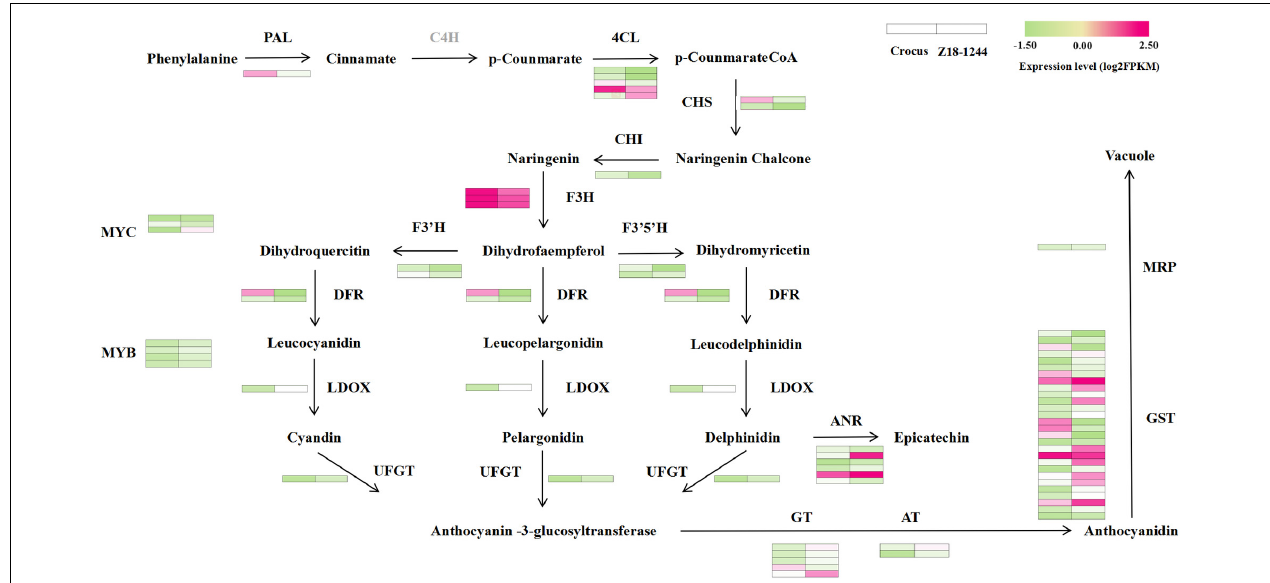
FIGURE 1 | Expression profiles of DEGs [|log2(fold change)| ≥ 1, FDR < 0.05] related to the anthocyanin biosynthesis and transport processes in blue and white aleurone. The color scale from green (low) to purple (high) represents the log2FPKM values measured in white and blue aleurones.